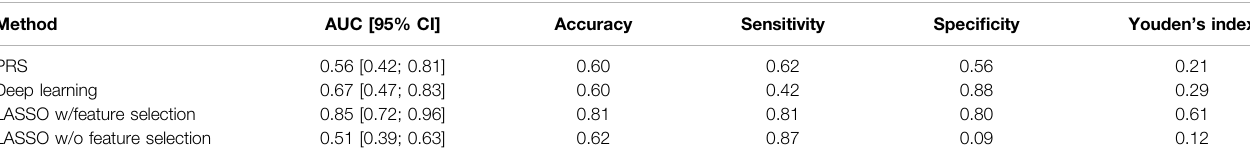
TABLE 2 | Performance comparison of all